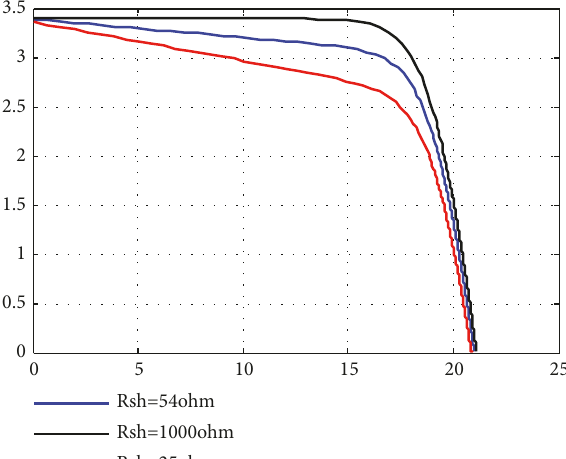
Figure 5: Influence of serie resistance on the 𝑃 𝑝 V = 𝑓(𝑉 𝑝 V ) characteristic.